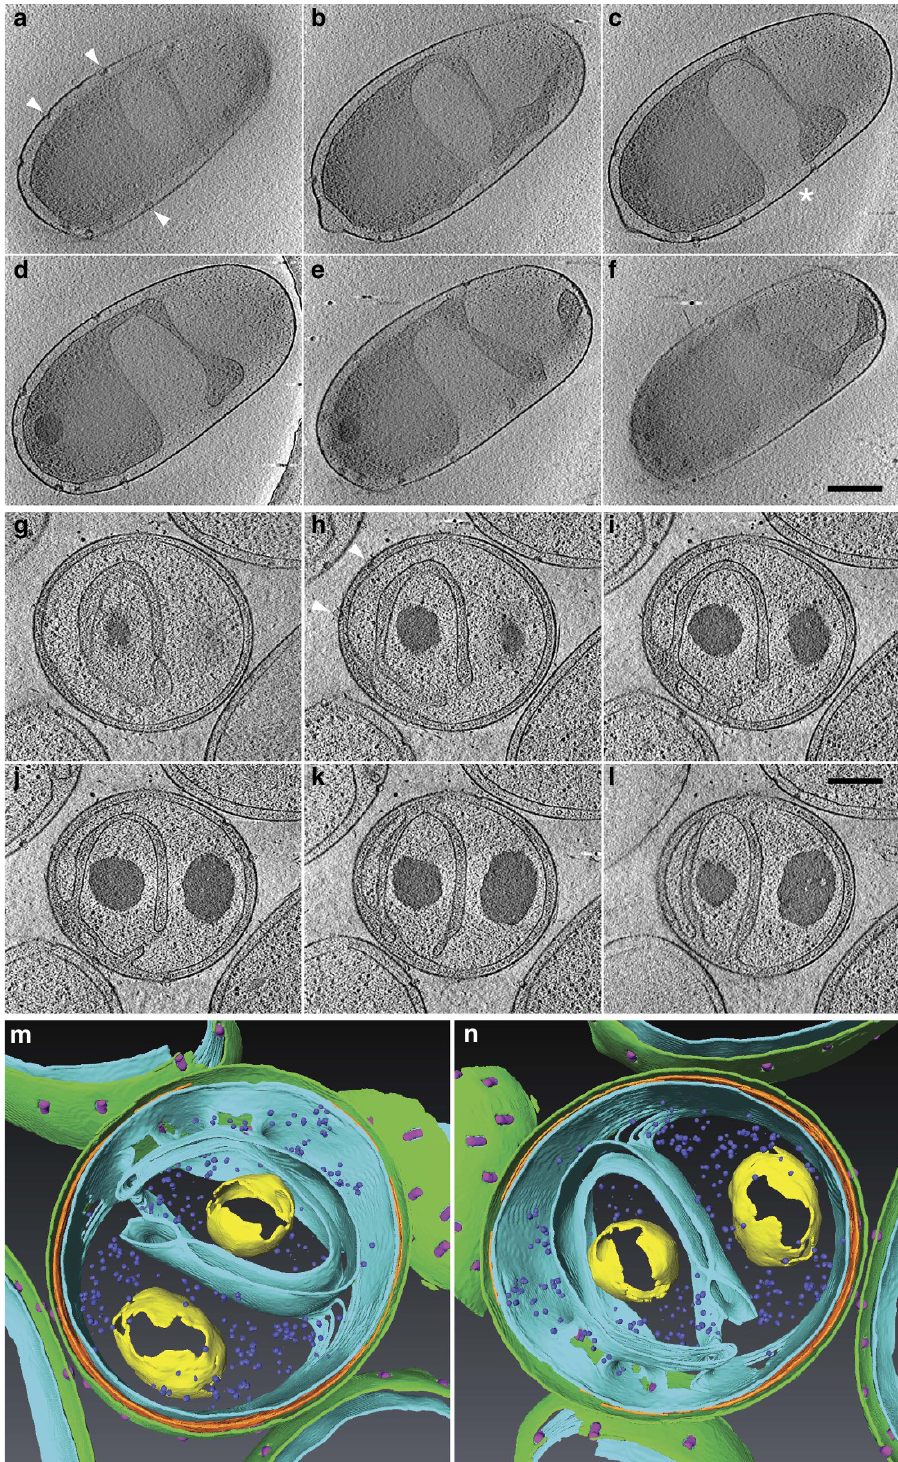
Figure 3 | Cryo-electron tomography of Planctopirus limnophila cells. ( a – f ) Representative slices of a whole cell tomogram with inter-slice distances of 71, 71, 64, 71 and 64nm from top left to bottom right (Supplementary Movie 1). The membrane is heavily invaginated and creates a huge periplasmic space. Crateriform structures (‘pits’) in the cell wall are always in close contact to the cell membrane (arrowheads) and are missing at sites of invagination (asterisk). ( g – l ) Slices of a tomogram of a cell thinned to 320nm by focused ion beam (FIB) micromachining. Inter-slice distances are 41nm throughout. Example of a cell with complex membrane invaginations creating a ‘channel system’ of the periplasm inside the inner cell volume. Scale bars, 250nm. ( m , n ) Surface-rendered reconstruction of the cell in ( g – l ) visualized in two different angles ( m , n ). Colour code: cell membrane (light blue), PG (orange), outer membrane (green), crateriform structures (purple), granules (yellow), ribosomes (dark